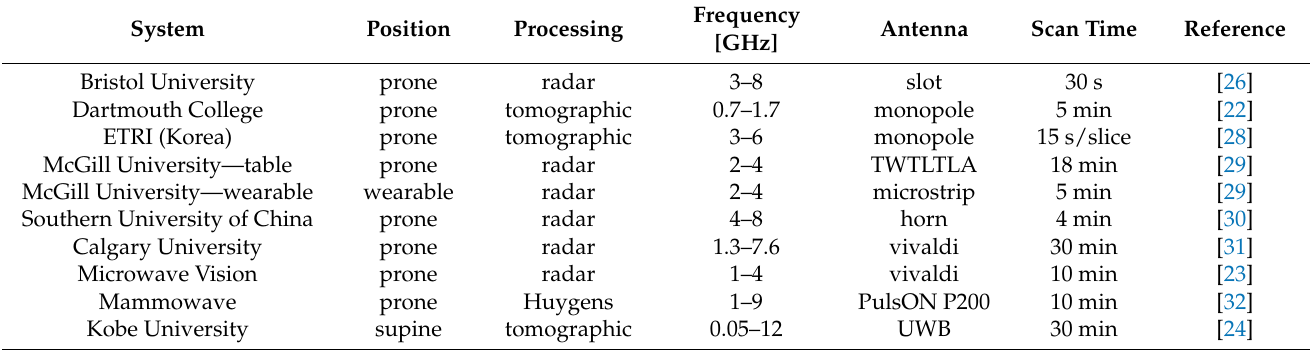
Table 1. Summary of main microwave breast imaging systems with studies on patients